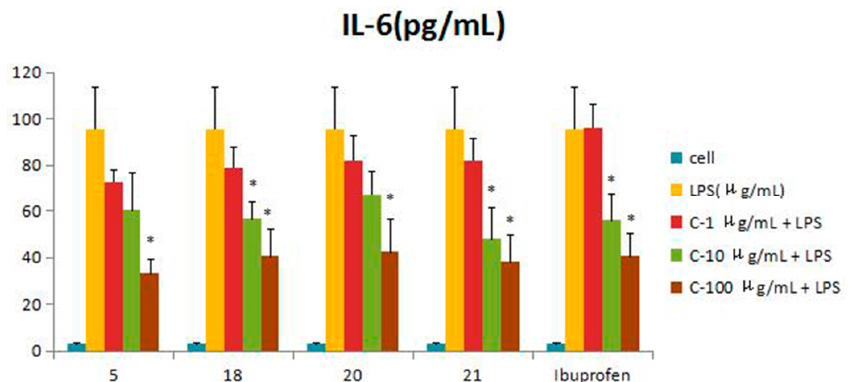
Figure 6. Inhibitory effects of Compounds 5 , 18 , 20 and 21 (1, 10, 100 μ g/mL) on IL-6 production stimulated by LPS (10 μ g/mL) in RAW 264.7 cells (mouse leukemic monocyte macrophage cell line). Data are expressed as the mean ± S.E.M. of three independent experiments. Cell: cultures were not exposed to lipopolysaccharide (LPS); LPS: cultures were subjected to LPS; LPS + Drug: compounds were added to the cultures during LPS; Positive control: LPS + Ibuprofen. ∗ p < 0.05 vs. LPS.